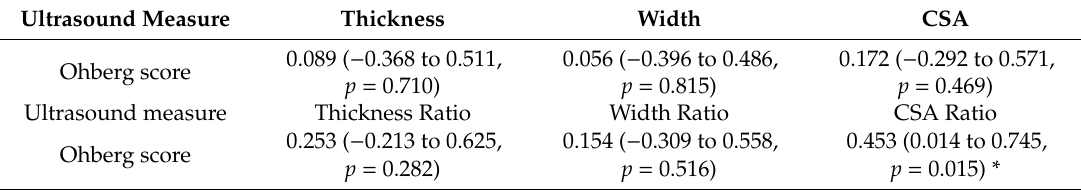
Table 7. Spearman (95% confidence interval) correlation test between ultrasound gross and ratio measures and neovascularization (Ohberg score) in non-elite sport players with unilateral patellar tendinopathy. Ultrasound Measure